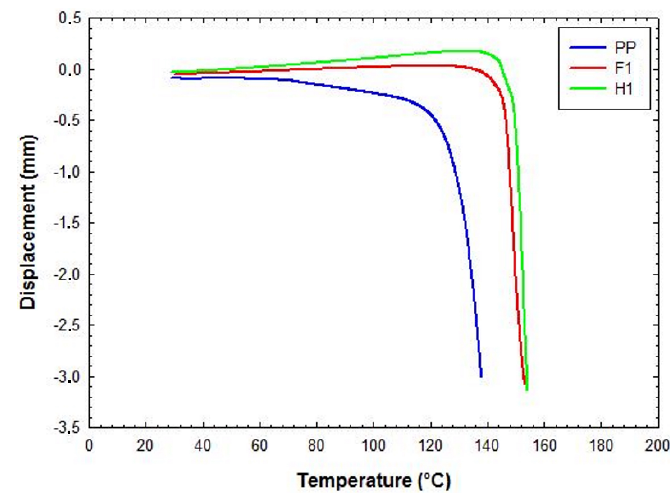
Figure 10. Displacement vs temperature curves carried out from HDT tests.